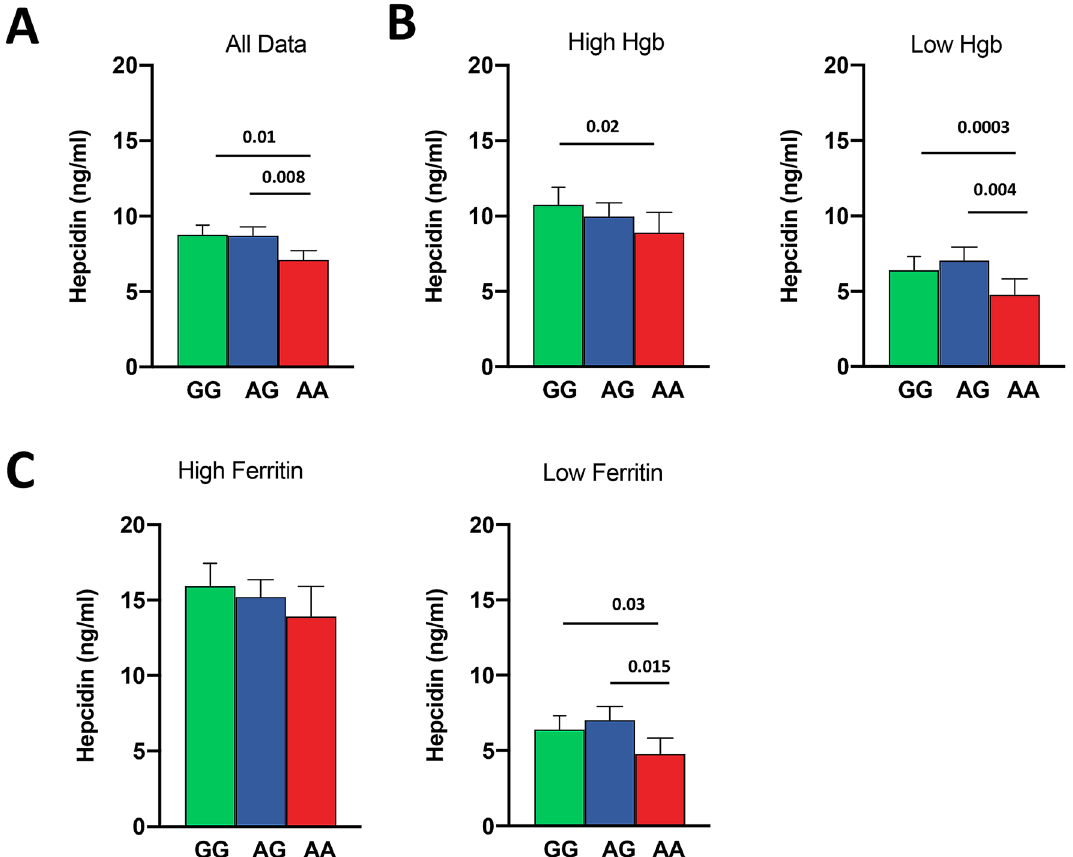
Figure 2. The effects of TMPRSS6 rs2235321 on plasma hepcidin levels. ( A ) All data (GG n = 416, GA n = 586, AA n = 262). ANOVA P for trend = 0.004. ( B ) Sample divided into high and low Hb (< 11.5 g/dl). High Hb (GG n = 245, GA n = 344, AA n = 162). ANOVA P for trend = 0.02. Low Hb (GG n = 171, GA n = 242, AA n = 100). ANOVA P for trend = 0.0002. ( C ) Sample divided above and below median ferritin (< 26 ng/ml). High ferritin (GG n = 247, GA n = 313, AA n = 155). ANOVA P for trend = 0.0004. Low ferritin (GG n = 169, GA n = 273, AA n = 107). ANOVA P for trend = NS.